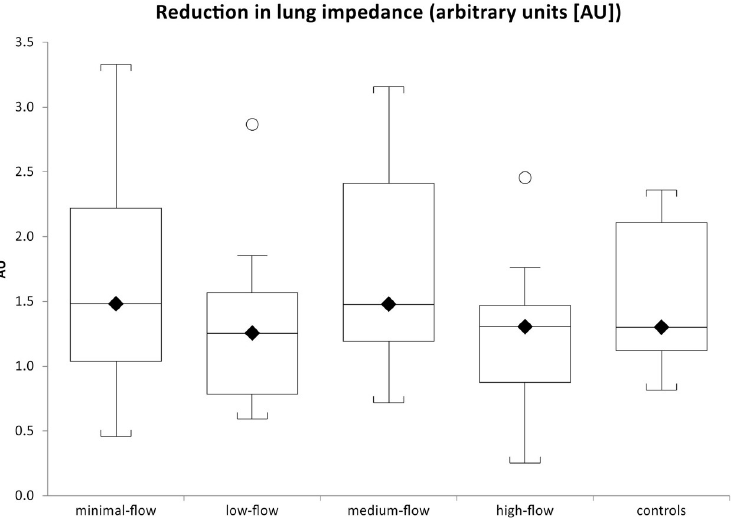
Fig 3. Total reduction in lung impedance normalized for impedance amplitude at tidal volumes of 6ml.kg -1 lean body weight at different flow rates. No significant differences between groups.